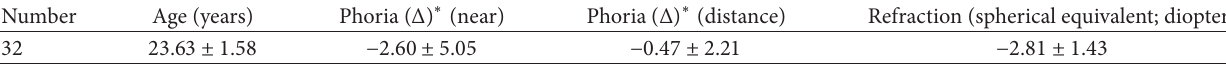
Table 1: Summary of the ocular status of observers before 3D TV viewing.